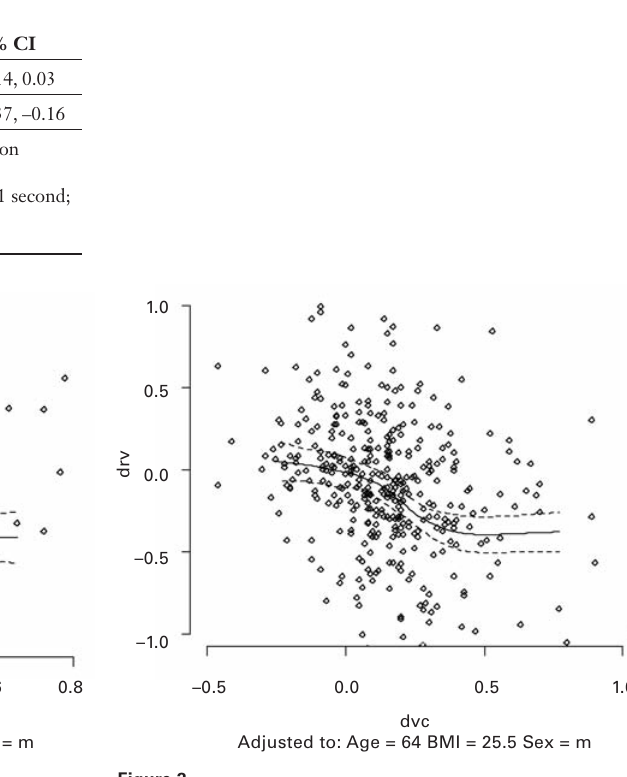
Adjusted multiple linear regression model showing a non- linear relationship between Δ FEV 1 compared to Δ RV after bronchodilation. d: difference in the value of the respective parameter before and after bronchodilation; RV: Residual volume in litre, FEV 1 : Forced expiratory volume in 1 second in litres.